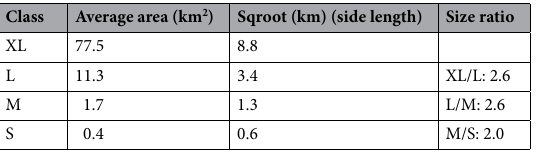
Table 3. Patch size ratio between settlements of different size classes in the Punjab of N-India.